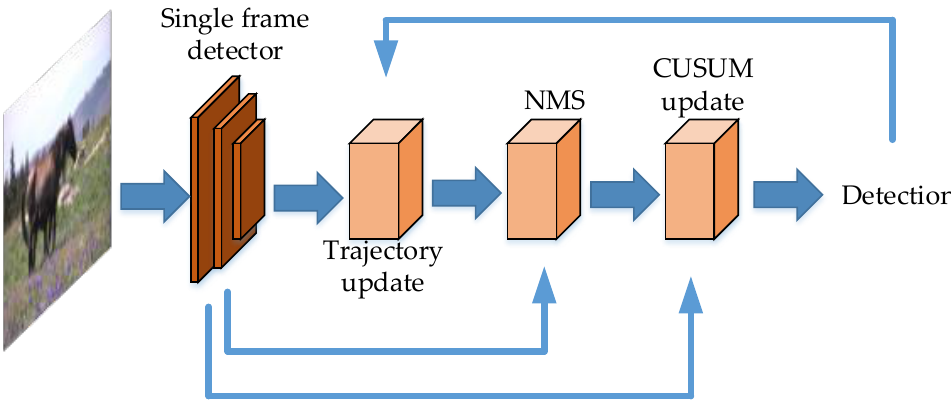
Figure 11. The structure of Minimum Delay video object detection. The single frame detector is a one-stage detector, and the rest is a two-stage detector (include feature extractor and classifier), thus we regard it as a mixed-stage object detector. The structure has two shortcut connections, and a feedback connection, which have improved the detection.